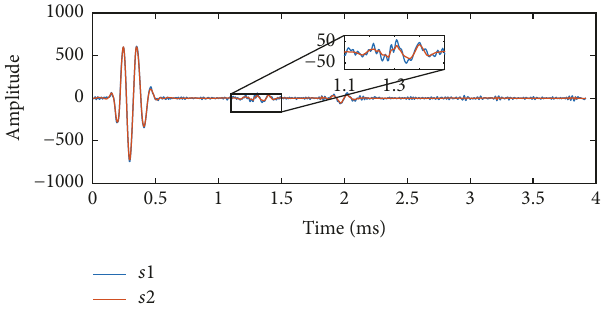
Figure 12: ICEEMD IMF2 versus ICEEMD-De